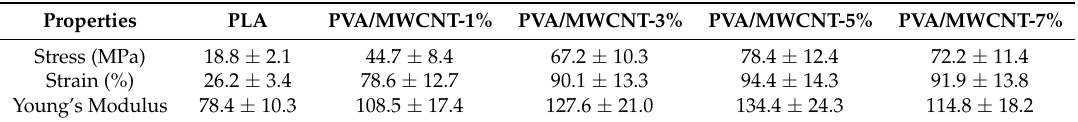
Table 1. Mechanical properties of PLA and the PVA/MWCNTs composite materials ( n = 6). Properties